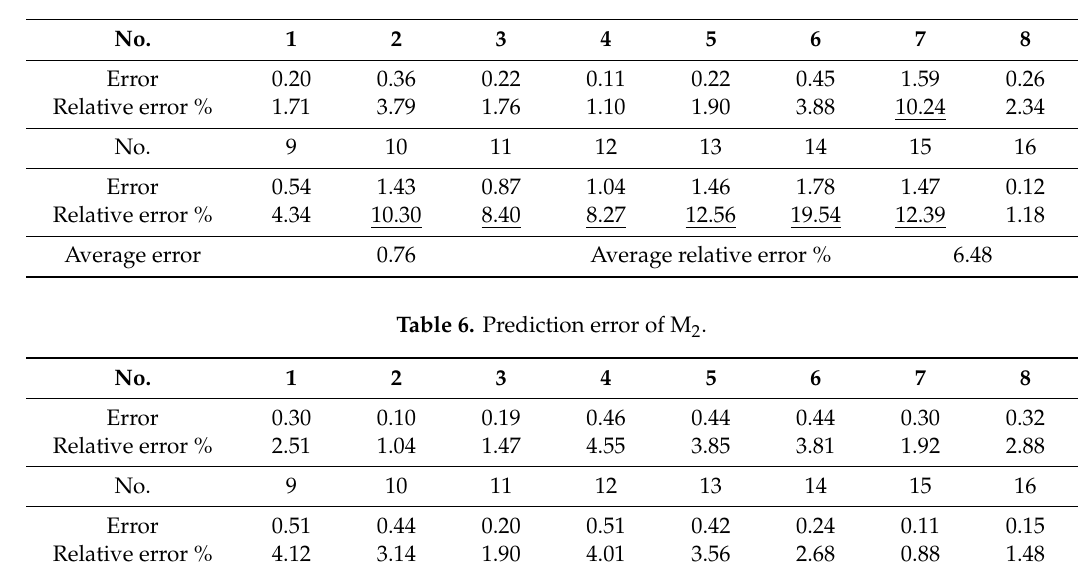
Table 5. Prediction error of M.